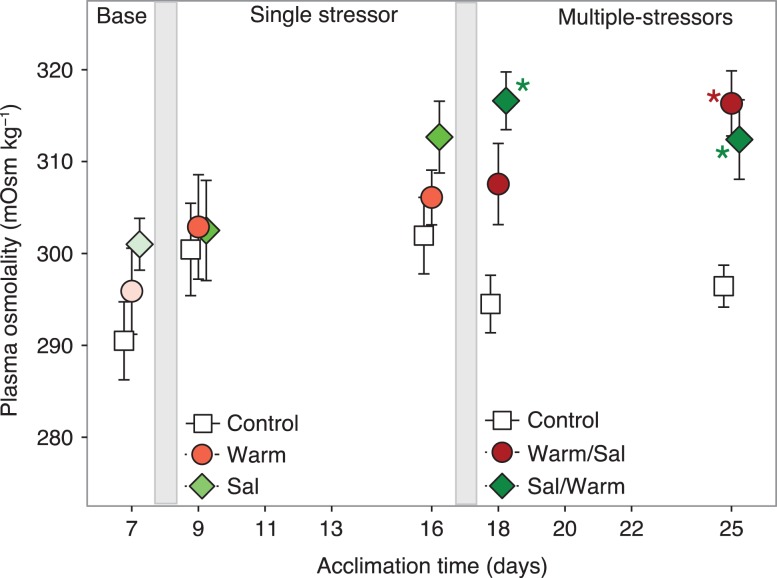
Largemouth Bass plasma osmolality across experimental stressor regimes. Each point represents the mean (±SE) of n = 9 for each acclimation time point and stressor regime. Asterisks indicate a difference between stressor Warm/Sal [THigh → THigh:SHigh, red] or Sal/Warm [SHigh → THigh:SHigh, green] from the Control ([TLow:SLow, white] within each day (lsmeans Tukey, P < 0.05). At 7 days (Base) all experimental regimes were at TLow:SLow.